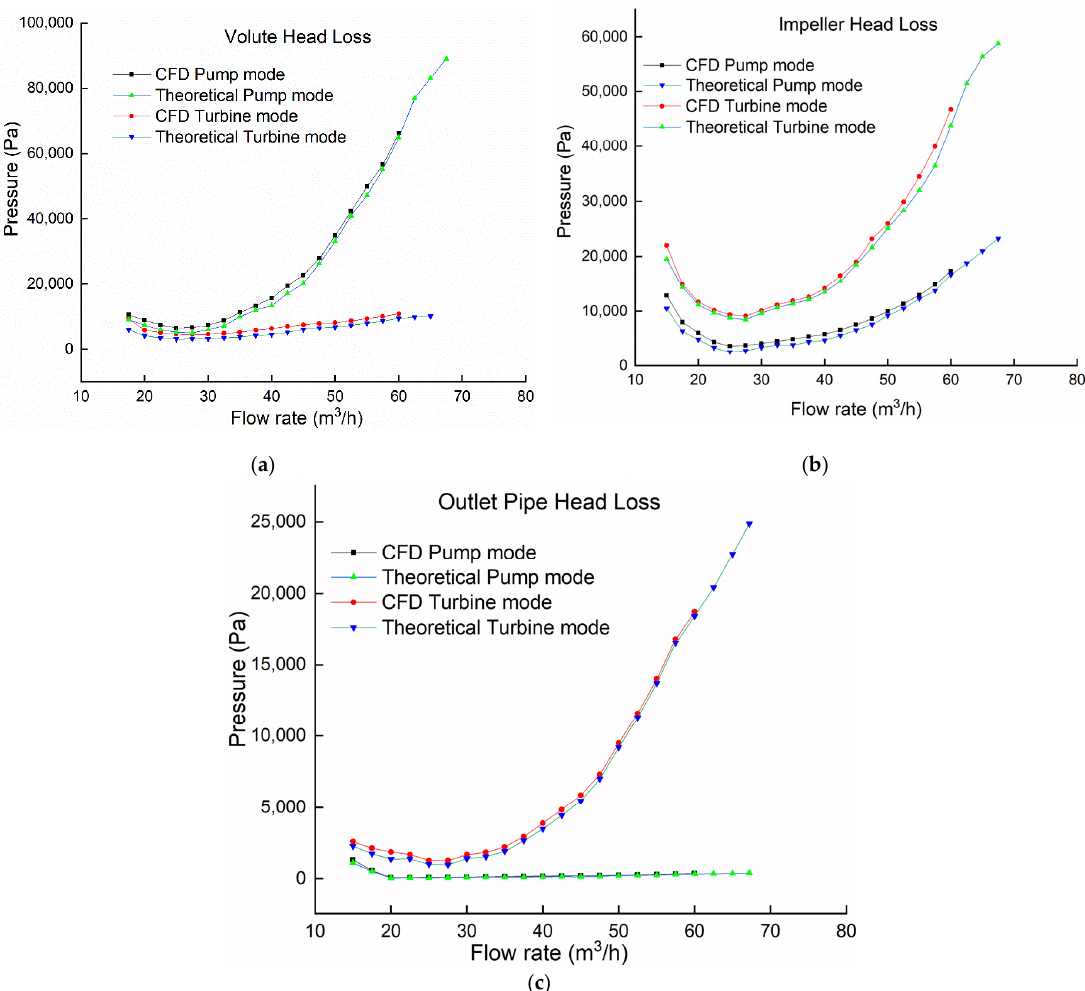
Figure 14. Magnitude of pressure head loss: ( a ) Volute ( b ) Impeller ( c ) Outlet pipe.